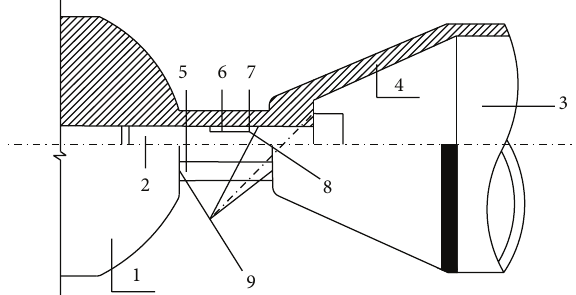
Figure 1: Bolt-ball joint with ball (1), ball (2), high strength bolt (3), steel tube (4), end cone (5), sleeve (6), slot (7), dowel pin (8), and deep-rich (9) contact